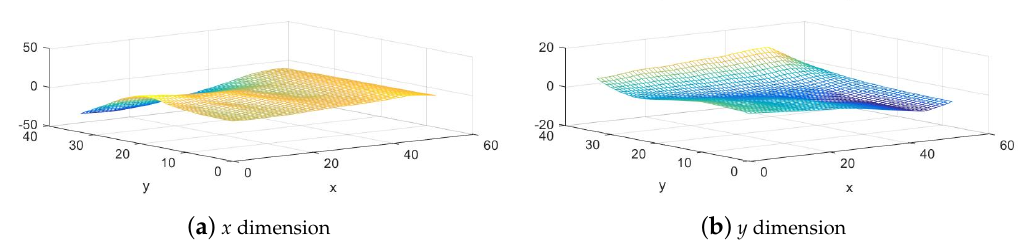
Figure 2. Nonrigid warp using mesh